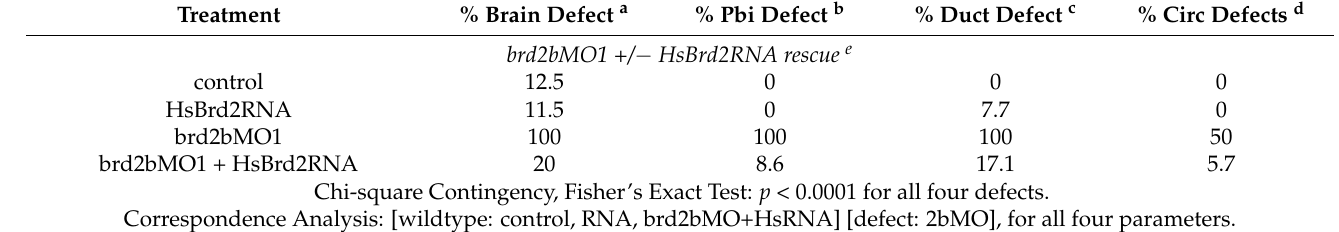
Table 1. Population morphology data: RNA rescue, knockdown and co-knockdown studies. Treatment % Brain Defect a % Pbi Defect b % Duct Defect c % Circ Defects